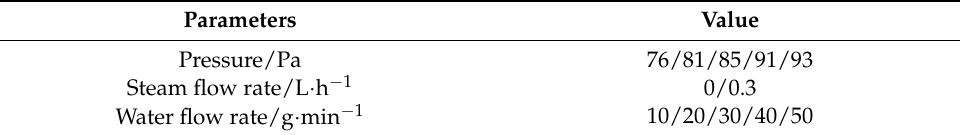
Table 1. Experimental conditions.